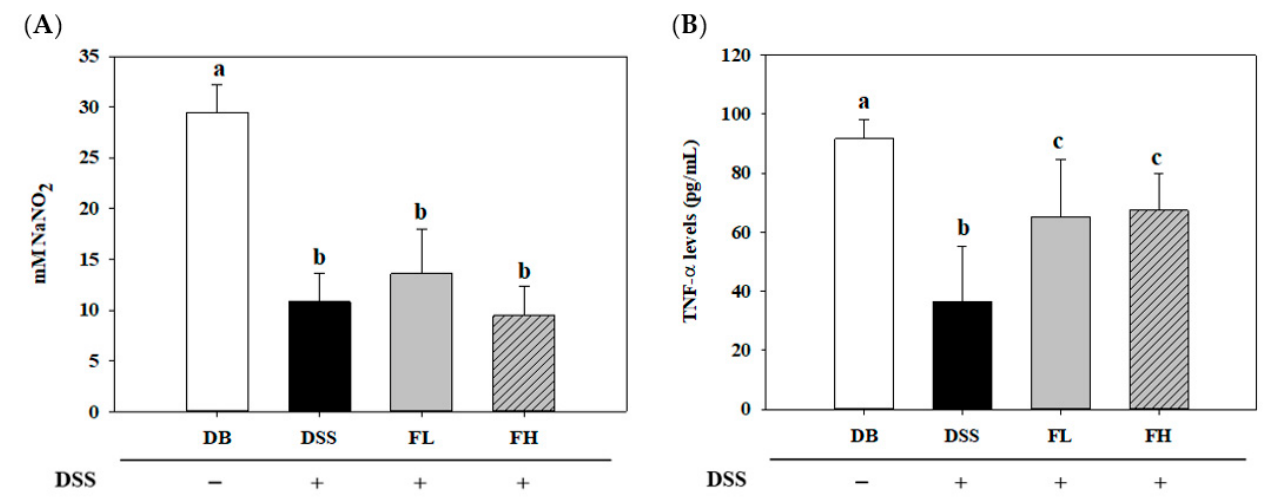
Figure 2. Effect of FMRP on nitric oxide (NO) ( A ) and TNF- α levels ( B ) in the serum. The DSS, FL, and FH groups were voluntarily administered 2% DSS in water ad libitum for 5 d. DSS +/ − indicates whether 2% DSS is treated or not. Different letters (a–c) denote a significant difference ( p < 0.05) calculated using one-way ANOVA with Tukey’s multiple comparison test. Data are expressed as means ± SD. Six mice were included per group.